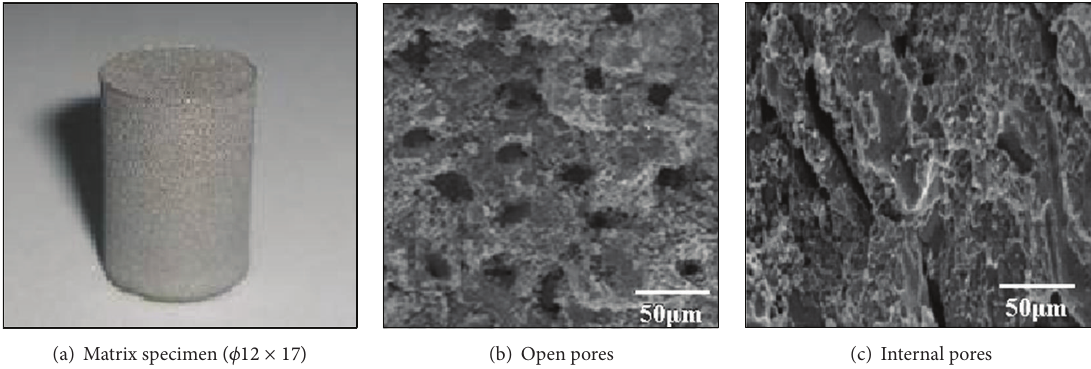
Figure 1: Porous ceramic matrix specimen and its interpenetrating microstructure (SEM).